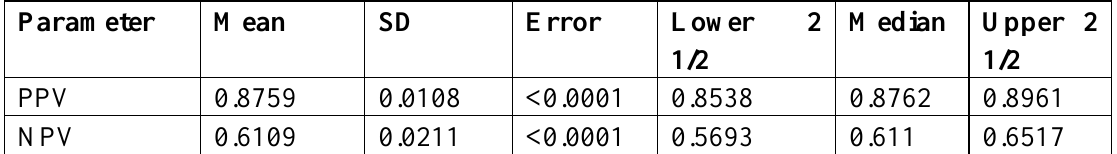
Table 4. Posterior distribution of predictive